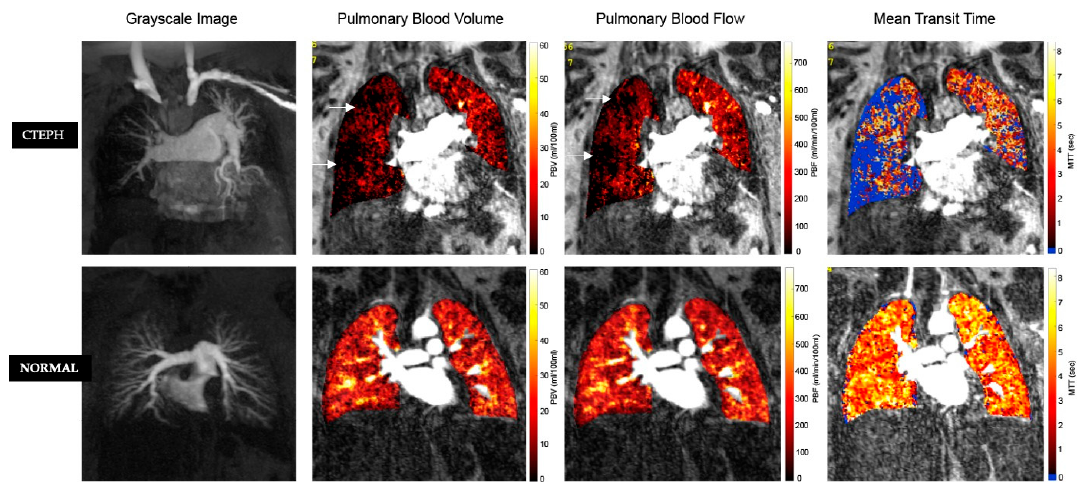
Figure 7. MR perfusion with absolute quantification of perfusion parameters. Top row: CTEPH. Bottom Row: Normal. From Left to Right: Maximum Intensity Projection (MIP) of MR pulmonary angiography, Pulmonary Blood Volume (PBV), Pulmonary Blood Flow (PBF), and Mean Transit Time (MTT). In chronic thromboembolic disease, there are focal areas (arrows) of wedge-shaped perfusion defects. In these areas of decreased perfusion, the mean PBF and PBV are decreased, and mean MTT is prolonged (colour